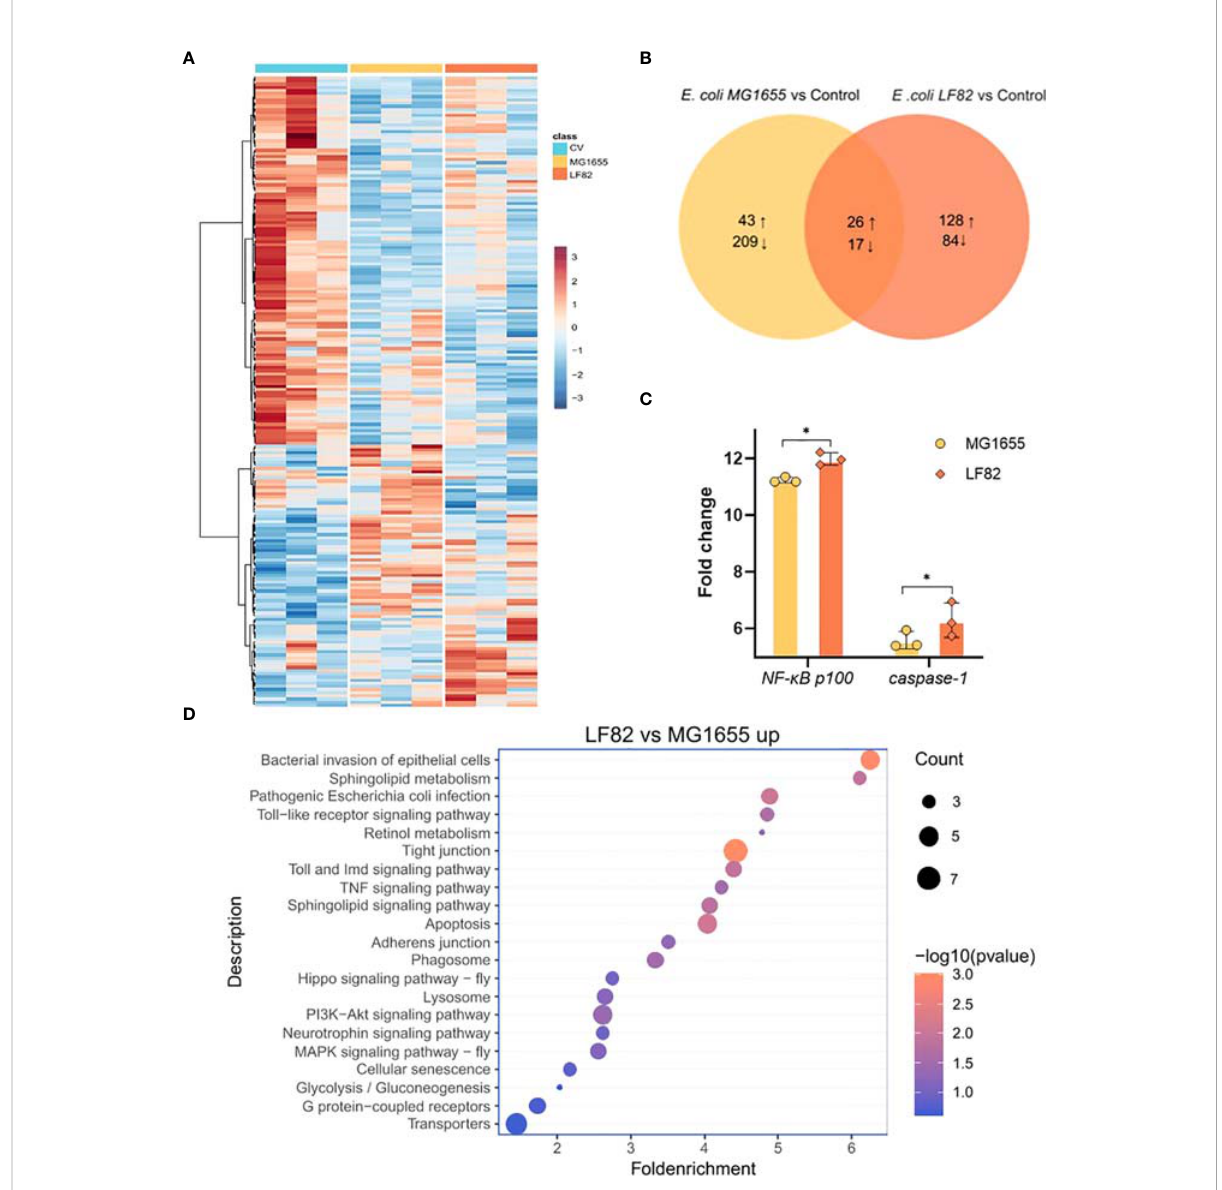
FIGURE 6 LF82 impacts gene expression in the honeybee brain. (A) Heatmap displaying the gene expression among the three different colonization groups. Colors indicate the normalized relative expression (minimum-maximum) for each gene. (B) Venn diagram representing the number of signi fi cantly differentially expressed genes (DEGs) between groups colonized with Escherichia coli LF82 and MG1655, respectively. Numbers show the sum of up- and down-regulated genes. (C) Fold change in transcript levels of the NF- k B and caspase-1 genes in the brain of honeybee colonized with MG1655 and LF82. (* p < 0.05) (D) Representative enriched KEGG pathways upregulated in the LF82 group compared with the MG1655